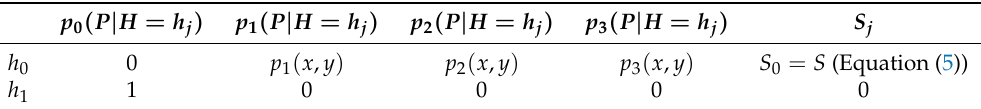
Table 1. Conditional probability p i ( P | H = h j ) of detection or non-detection of particles in cell ( x , y ) and conditional entropy S j for various outcomes of hole